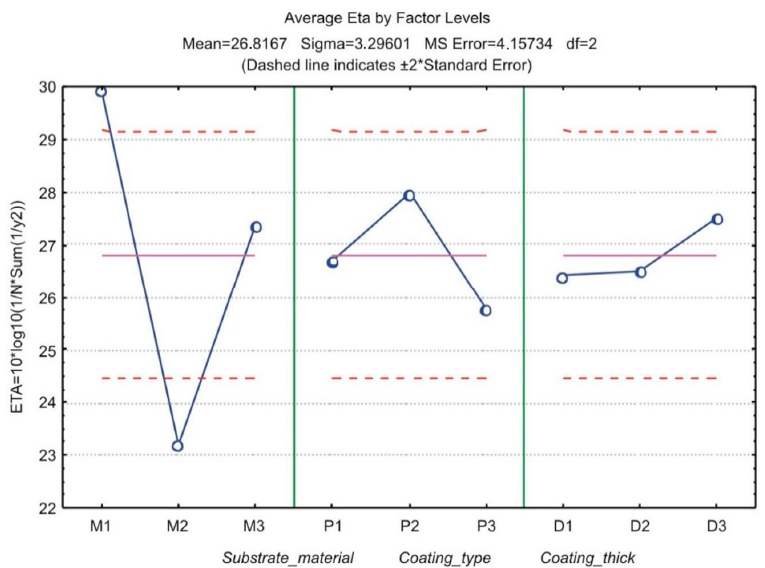
Figure2. CommongraphicalpresentationofS / N(signal-to-noise)ratios(ETA)afterapplyingtheTaguchi Figure 2. Common graphical presentation of S/N (signal-to-noise) ratios (ETA) after applying the method Taguchi method [8].